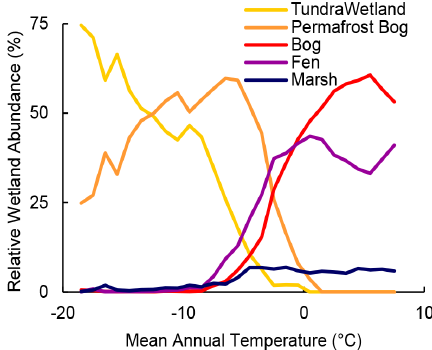
Figure 3. Relative abundance of the five wetland classes across a gradient of mean annual